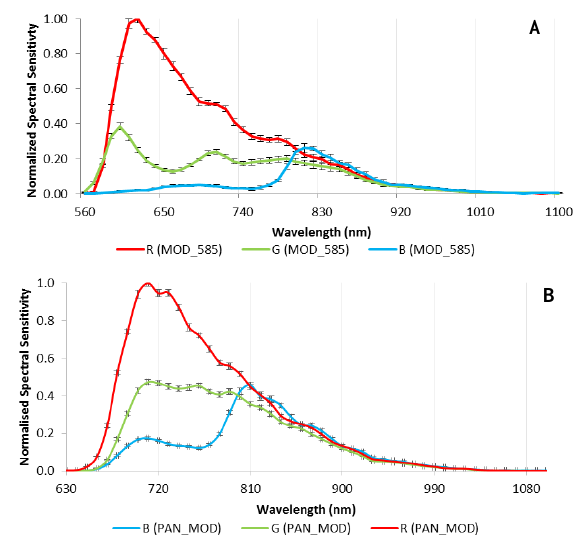
Figure 6: Spectral response for the modified to full spectrum Canon with with a 585 nm long pass filter (A) and for the modified Panansonic camera (B), both normailised to the peak of the red